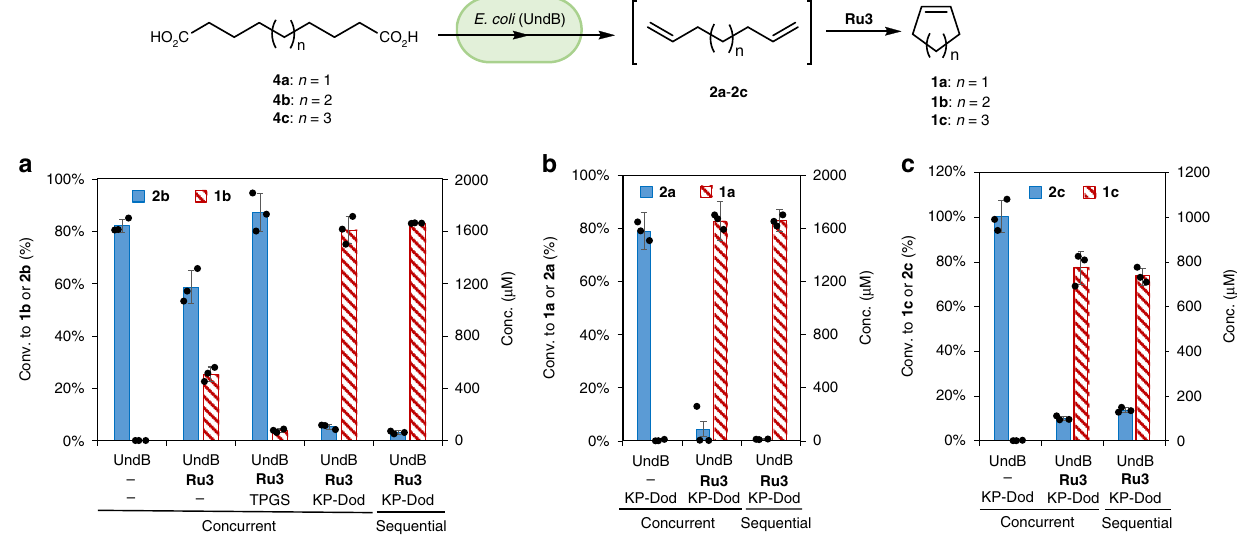
Fig. 4 Bis-decarboxylation-metathesis cascade for the conversion of diacids ( 4a - 4c ) to cycloalkenes ( 1a - 1c ). a Concurrent or sequential cascade for the conversion of diacid 4b (2 mM) to 1b in the presence of E. coli (UndB) (10 g l − 1 ) and Ru3 (100 μ M) in KP buffer (200 mM, pH 8.0, 1% glucose), KP buffer and n -dodecane (10%) or KP buffer and TPGS-750-M (1%) at 30 °C for 24 h. b One-pot conversion of diacid 4a (2 mM) to cyclopentene ( 1a ) with E. coli (UndB) (10 g l − 1 ) and Ru3 (100 μ M) in KP buffer (200 mM, pH 8.0, 1% glucose) with n -dodecane (10%) at 30 °C for 24 h. c One-pot conversion of diacid 4c (1 mM) to cycloheptene ( 1c ) with E. coli (UndB) (10 g l − 1 ) and Ru3 (50 μ M) in KP buffer (200 mM, pH 8.0, 1% glucose) with n -dodecane (10%) at 30 °C for 24 h. For the sequential mode, Ru3 was added at 24 h and reacted for another 24 h (total 48 h). Source data are provided as a Source Data fi le. Data are mean values of triplicate experiments with error bars indicating standard deviations ( n =